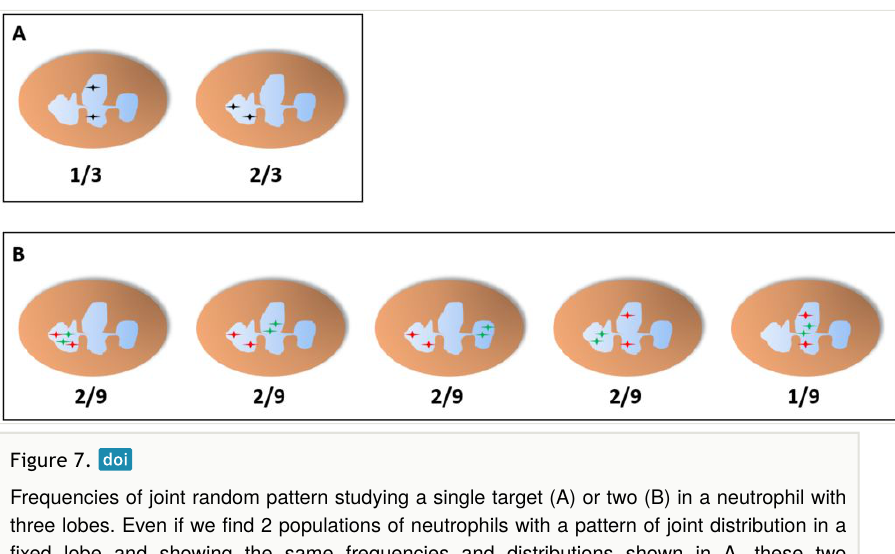
Frequencies of joint random pattern studying a single target (A) or two (B) in a neutrophil with three lobes. Even if we fi nd 2 populations of neutrophils with a pattern of joint distribution in a fi xed lobe and showing the same frequencies and distributions shown in A, these two found before if the pattern is not actually independent of the